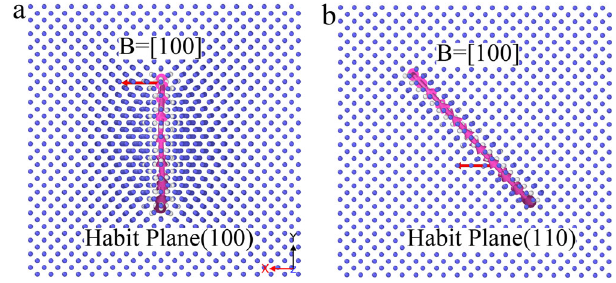
Fig. 2 Schematic of diffusion mechanisms of a <100> loop on the (100) habit plane with b = [100]. Its habit plane can change from the a (100) to the b ( (cid:1) 310), the c ( (cid:1) 210), and the d ( (cid:1) 110) (path 1) or to the e (30 (cid:1) 1), the f (20 (cid:1) 1), and the g (10 (cid:1) 1) (path 2). The schematic of two paths and the cross point are shown on the right side h . The different habit planes are marked by the purple, green, and blue, respectively.